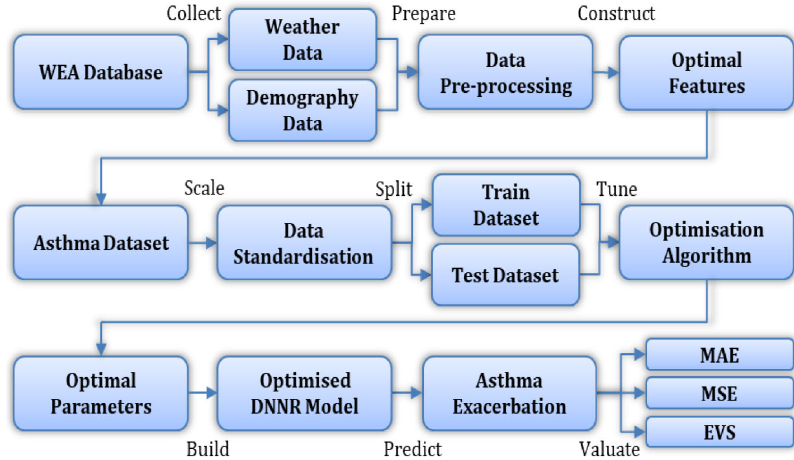
Figure 6. Optimisation process. Table 3. Actual vs. predicted